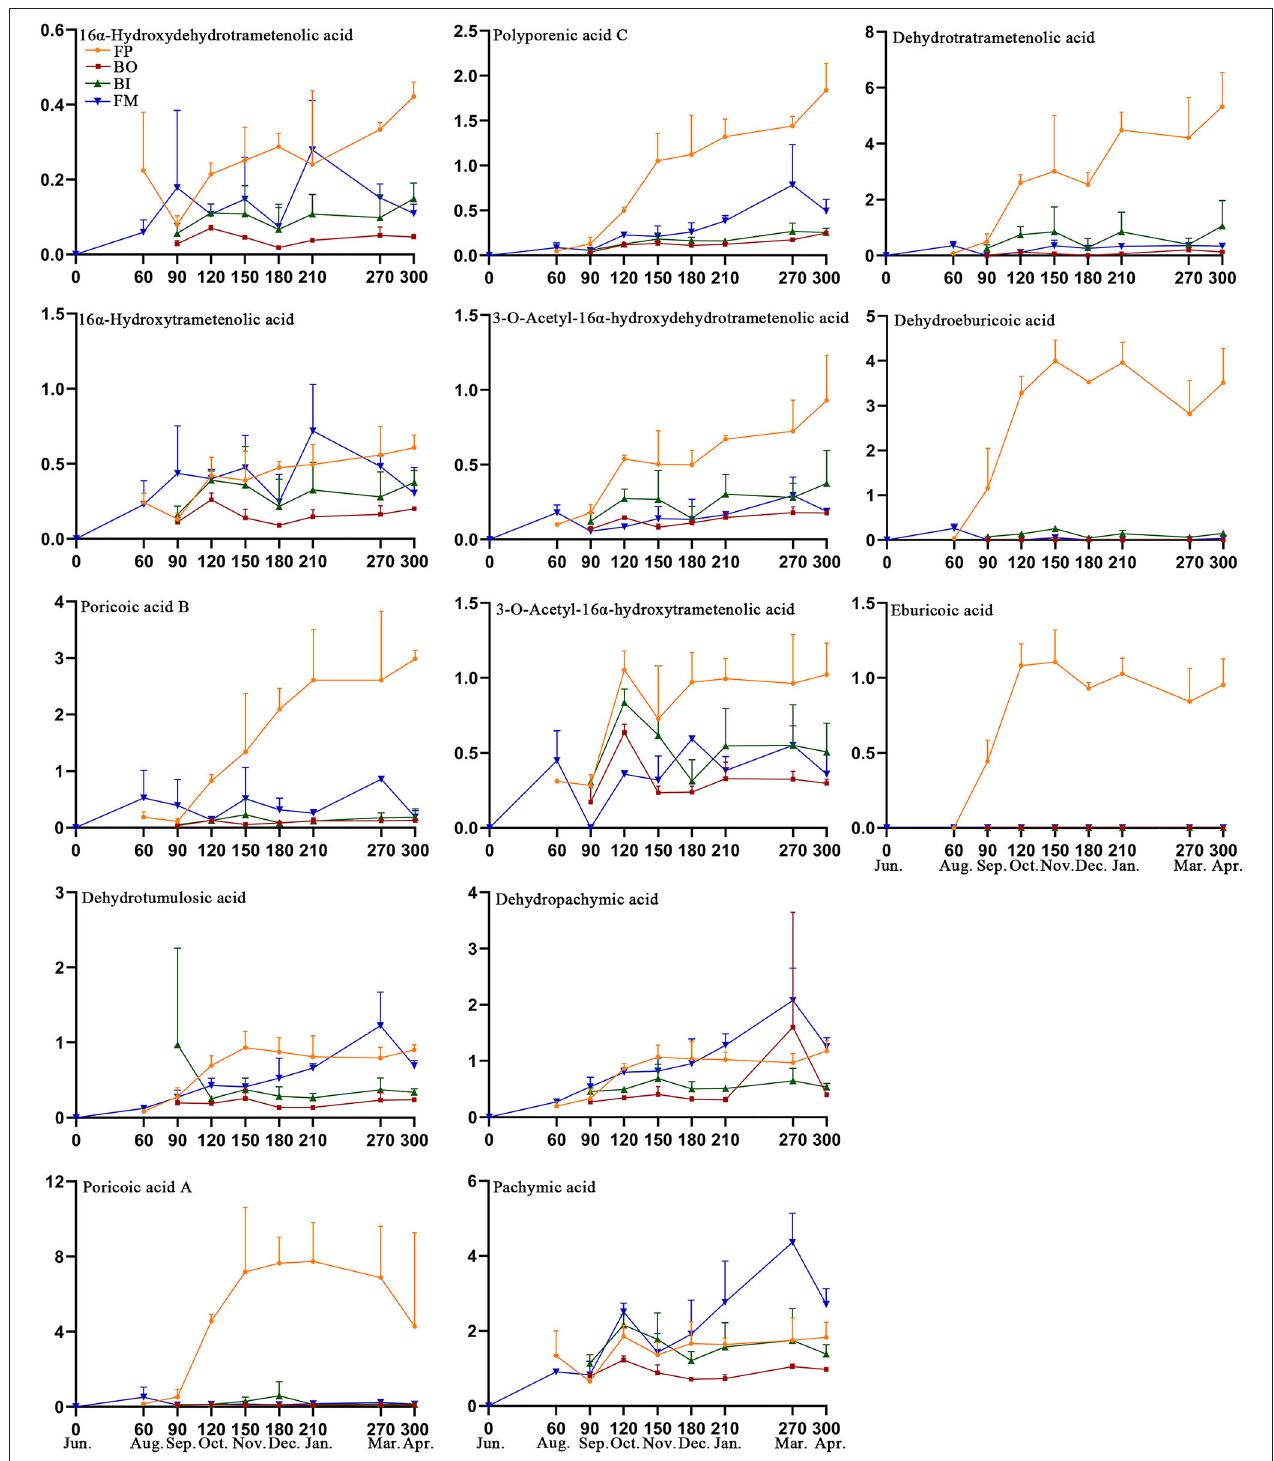
FIGURE 6 | Content levels (mg/g) for 13 triterpenoid acids in the four parts of Fushen at nine growth periods. also differences in the effective compounds during different the harvest time for Fushen was not fixed. However, there is growth periods (Gao, 2015). In our study, there were obvious a close relationship between the harvest time and the resultant quality of the derived traditional Chinese medicines. There are differences in the specialized metabolites of the Fushen in the